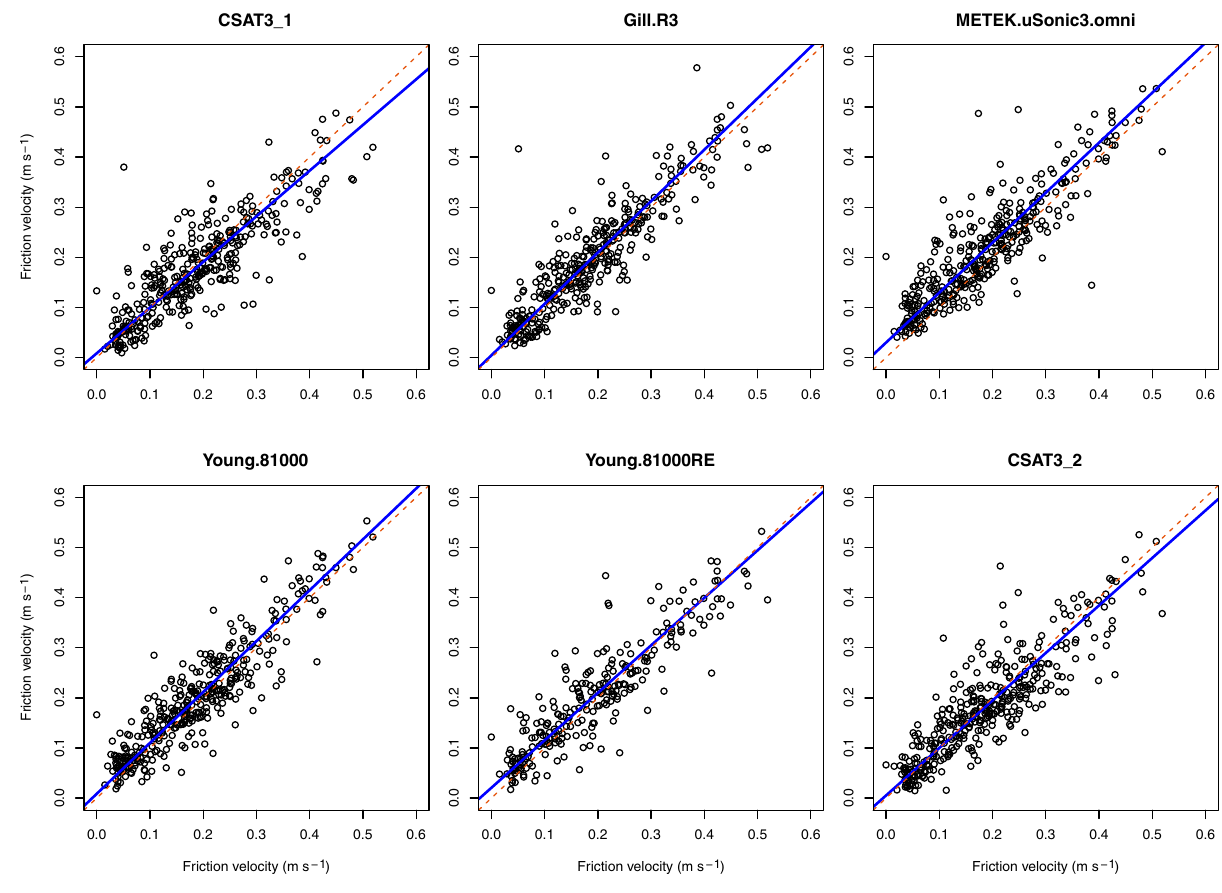
Figure 8. Comparison of the friction velocity measurements (etalon = Gill.HS). Table 6. Regression results for the comparison of friction velocity u ∗ , plus estimates for bias and comparability (RMSE); unusually large deviations from the etalon are in bold (slopes deviating more than 5% from unity). Etalon = Gill.HS